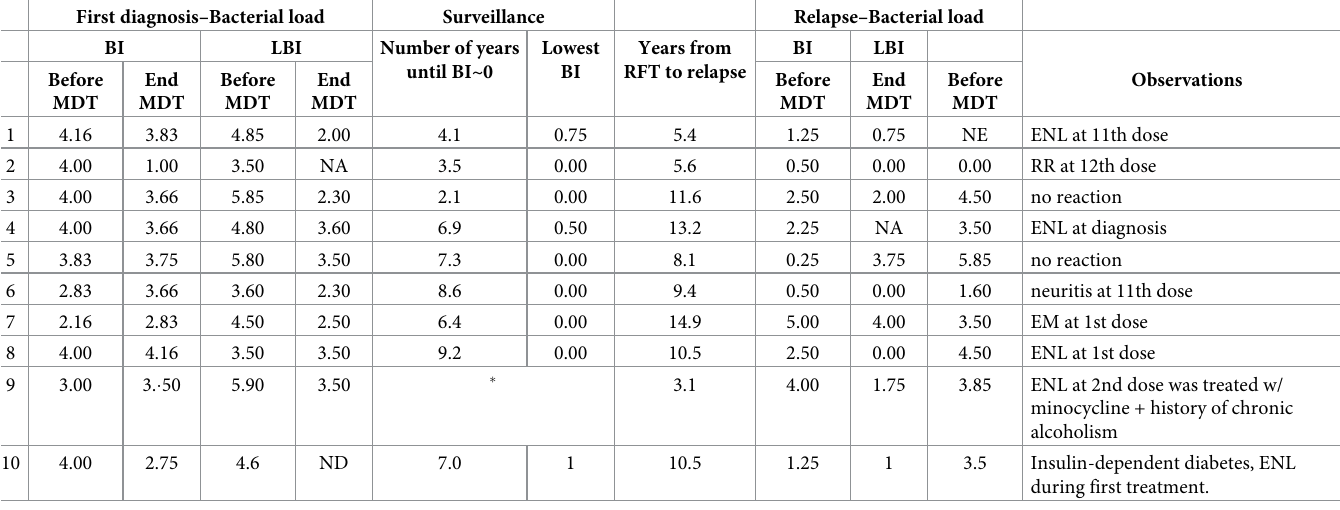
Table 3. Laboratory characteristics of the ten patients diagnosed with Hansen disease